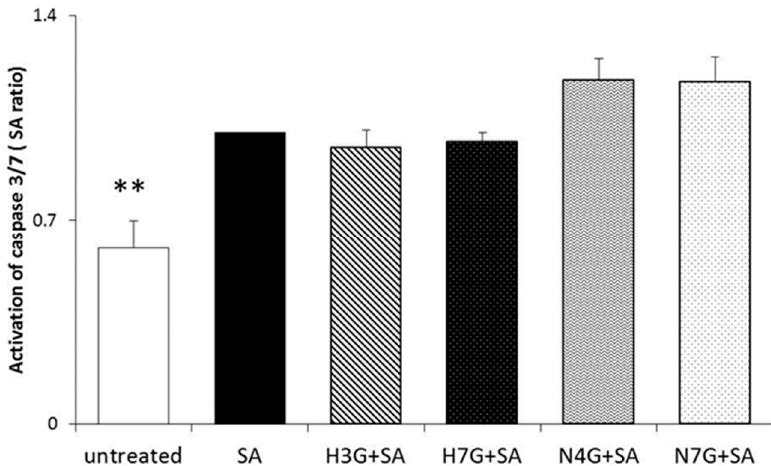
Figure 3. Effects of flavanone metabolites on apoptosis. Caspase 3/7 activation in myeloid angiogenic cells (MACs) pre-incubated with naringenin-7- O -glucuronide (N7G), naringenin-4 ′ - O -glucuronide (N4G), hesperetin-7- O -glucuronide (H7G) and hesperetin-3 ′ - O -glucuronide (H3G) at 1 μ M for 16 h and then exposed to stearate (SA, 100 μ M) for 24 h. Vehicle (DMSO 0.1%) was used as control (untreated) and results are expressed as means ± SEM (** p < 0.01 vs. stearate; n = 8).